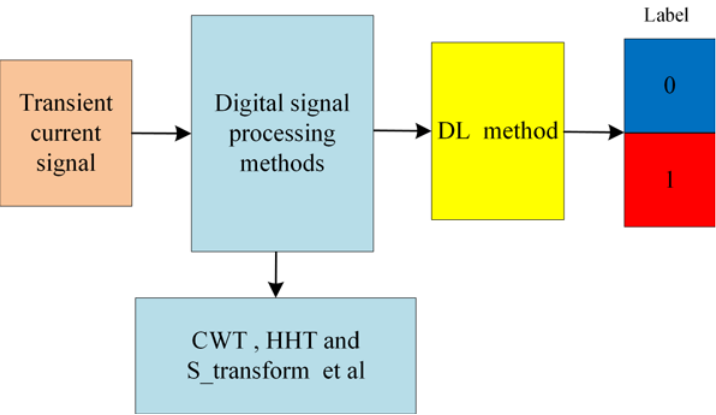
Figure 2. Flow chart of Option 2. If it is a faulty feeder, the output label is ‘1’; otherwise, the output label is ‘0′.